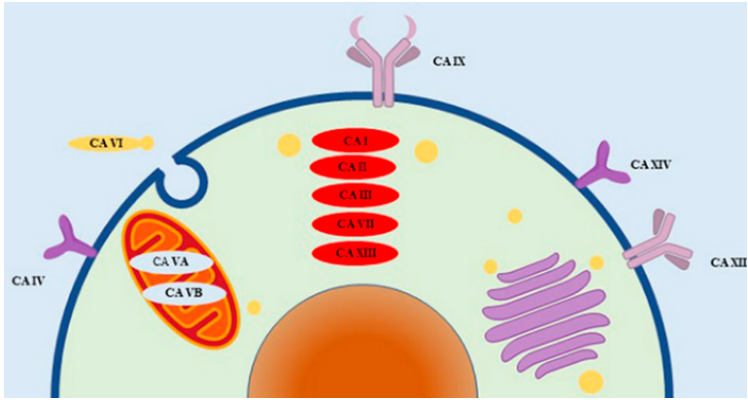
Figure 1. Subcellular distribution of h CAs.